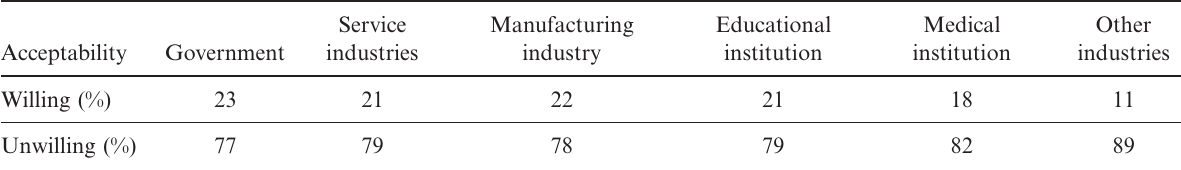
Table 5. Policy acceptability in terms of industry